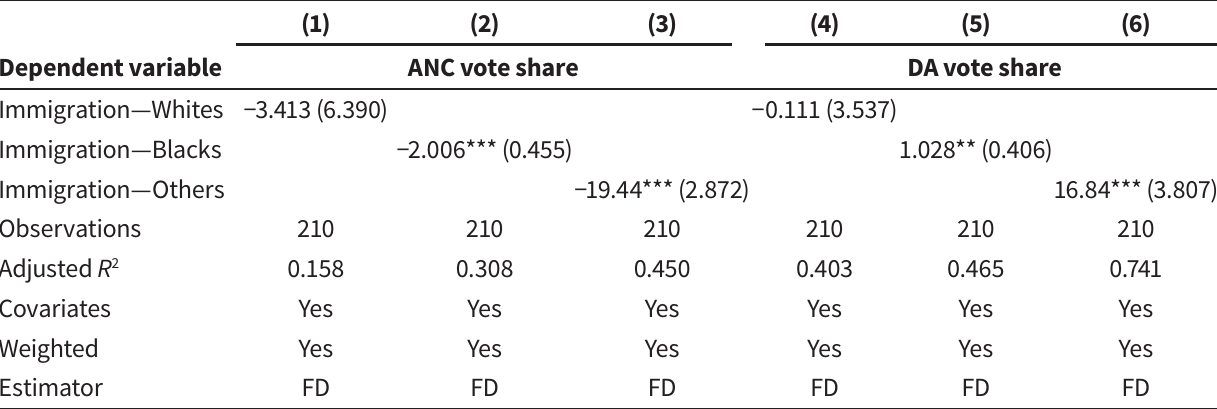
Racial background of